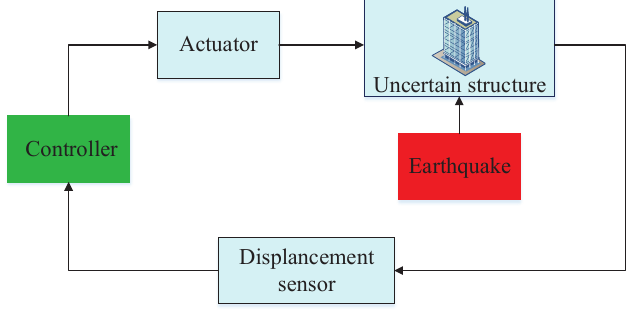
Figure 1. Vibration control system of uncertain building